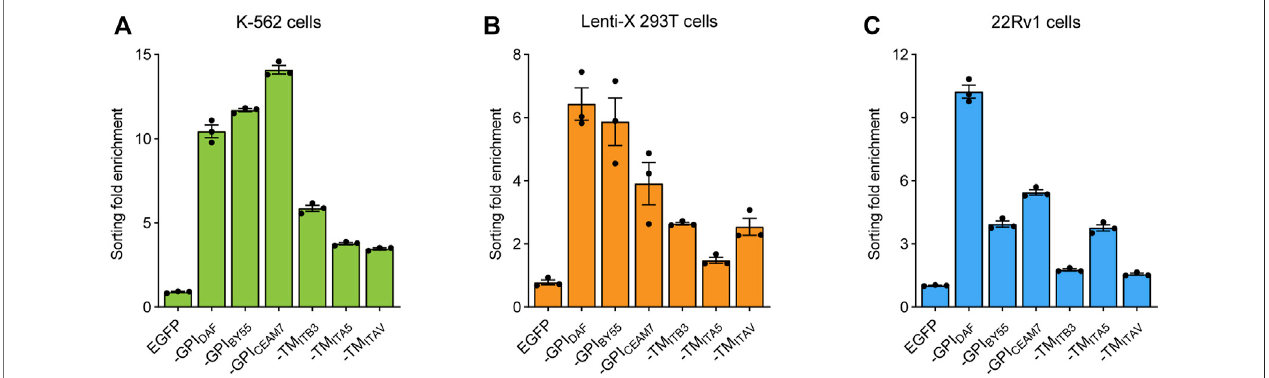
FIGURE 4 | Cell sorting fold enrichment of the EGFP expression. Bar chart showing the enrichment fold of EGFP RNA expression level after cell soring using six sortingtagsinK-562 (A) ,Lenti-X293T (B) ,and22Rv1cells (C) ,respectively.Thefoldenrichmentrepresentsthechangeofthe β -actinreferencegene-normalizedEGFP expression level after cell sorting. The cells transfected with pEGFP-C2 plasmids were used as the negative control. The values come from three RT-qPCR replicates.